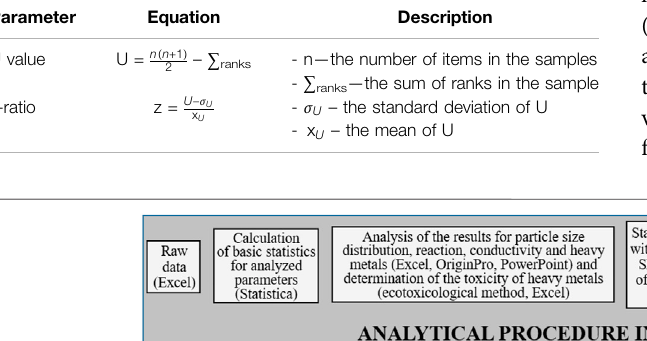
TABLE 2 | The method of calculating parameters in the Mann-Whitney U Test. Parameter Equation Description